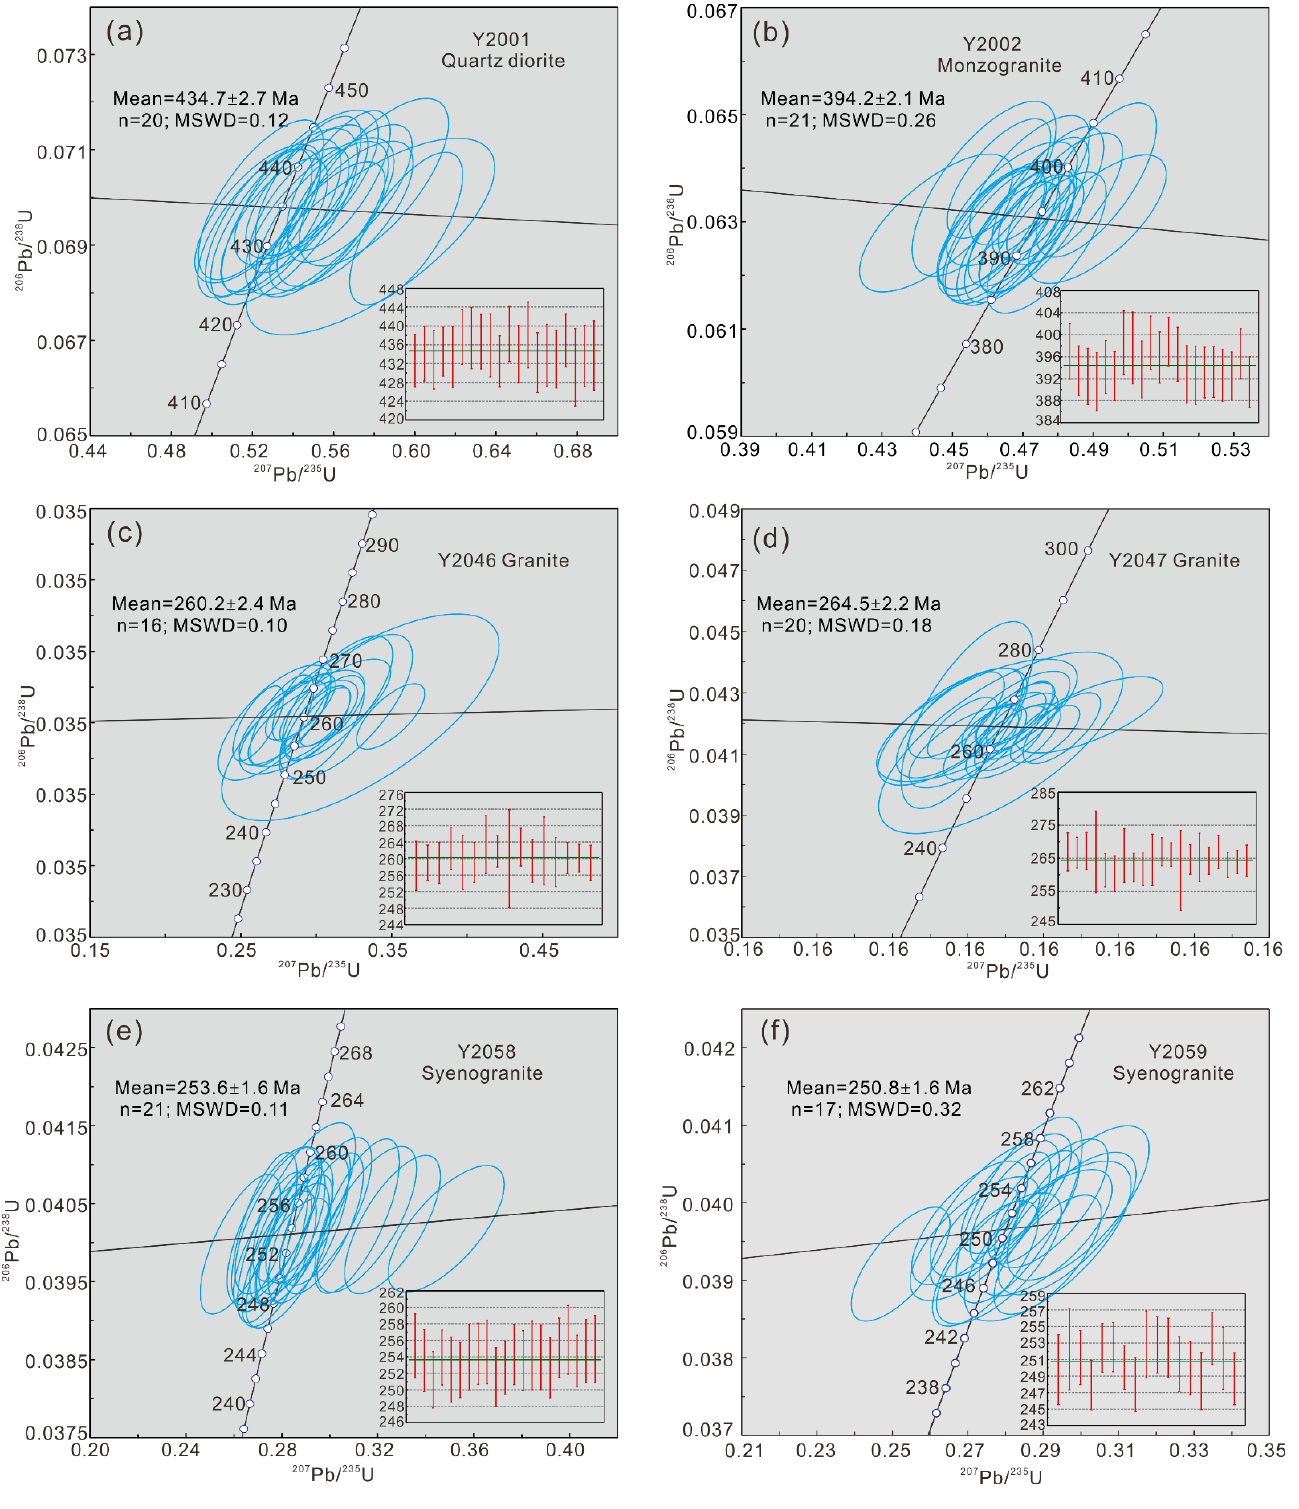
Figure 6. U-Pb concordia diagrams and weighted mean age for zircons from analyzed samples. ( a ) quartz diorite sample (Y2001); ( b ) monzogranite sample (Y2002); ( c , d ) granite sample (Y2046, Y2047); ( e , f ) syenogranite sample (Y2058, Y2059).